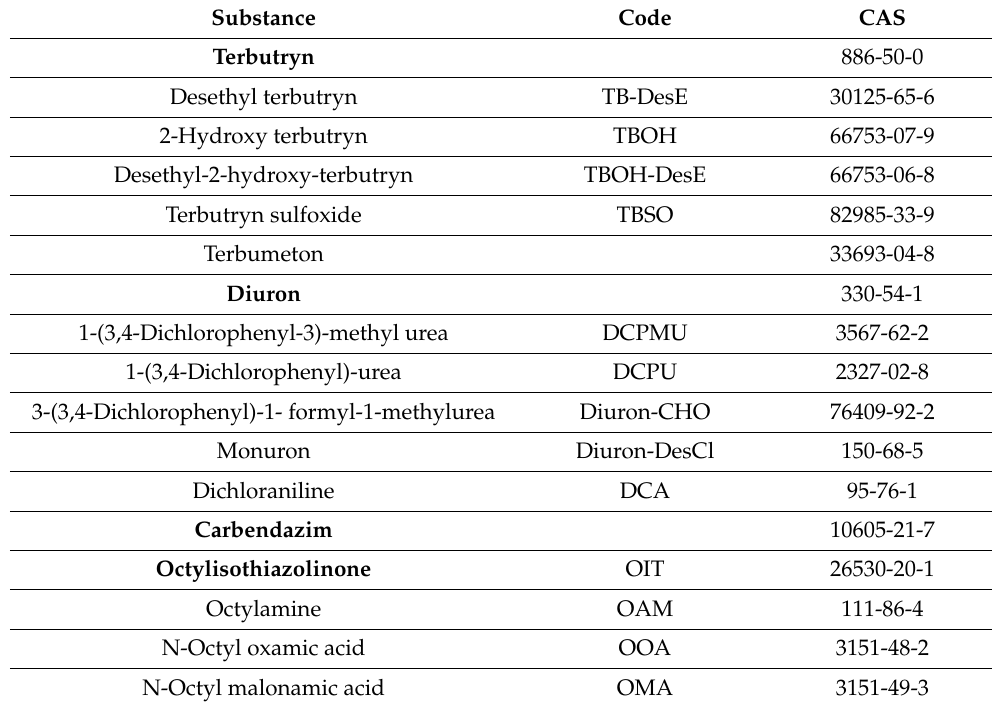
Table 1. Analyzed active substances (bold) and transformation products. Substance